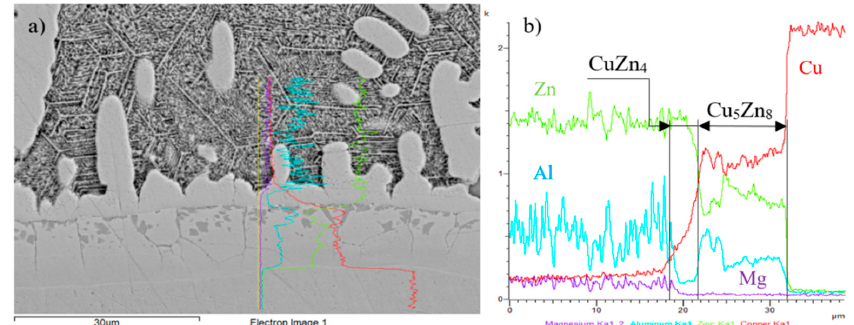
Figure 19. EDX analysis of the Cu/Zn5Al3Mg boundary; ( a ) microstructure of examined boundary; ( b ) concentration profiles of Zn, Cu, Al and Mg elements.